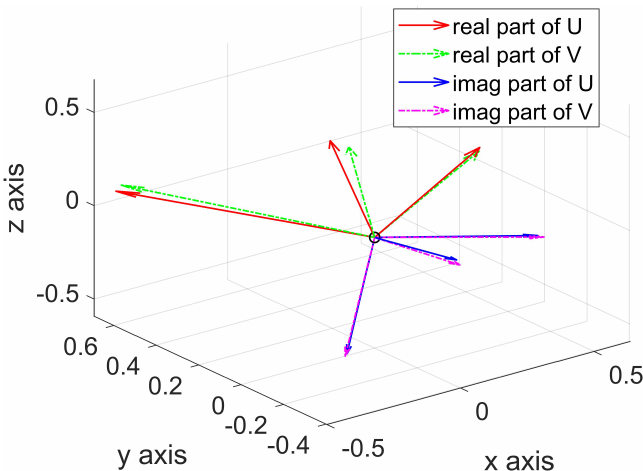
Figure 2. The example of the eigenvectors. U is the eigenvector matrix of T − 1 A k and V is the eigenvector matrix of T − 1 A k + 1 . The eigenvectors are the columns of U and V. The arrows denote the eigenvectors in the 3-D